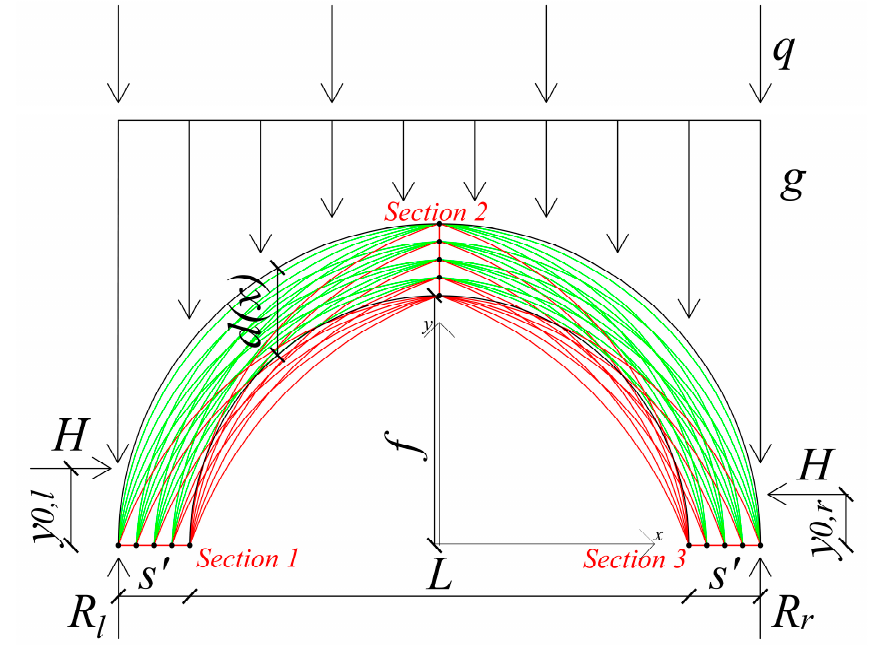
Figure 4. Accepted (green) and rejected (red) lines of thrust.